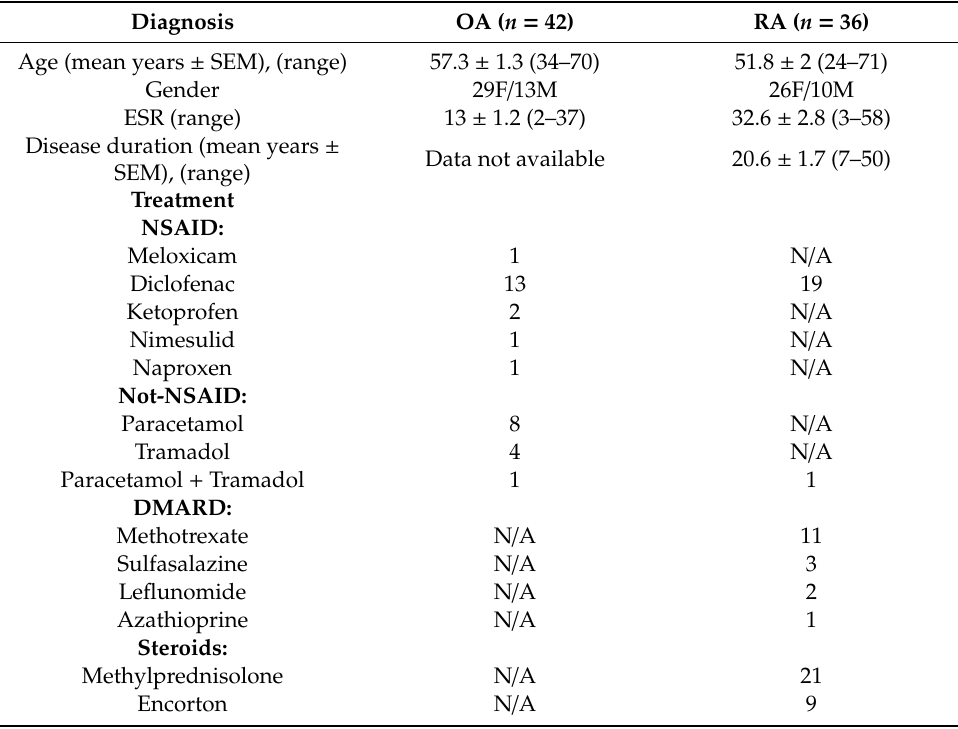
Table 1. Summary of clinical data of patients included in the